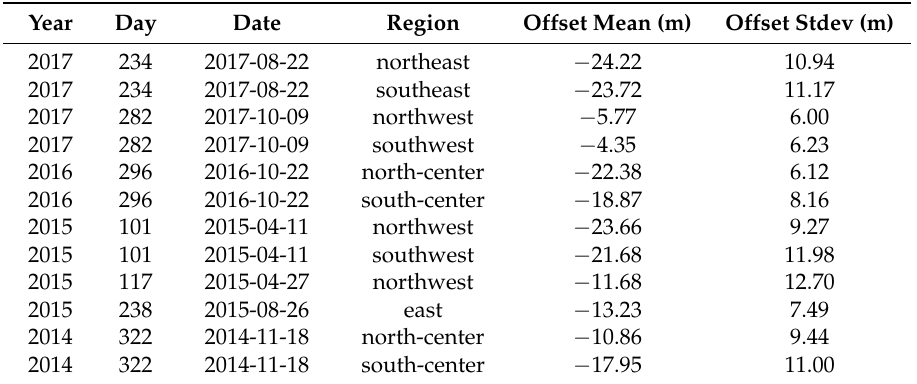
Table 3. Advanced Spaceborne Thermal Emission and Reflection Radiometer (ASTER) DEM tiles (AST14) and their measured offsets from the SRTM